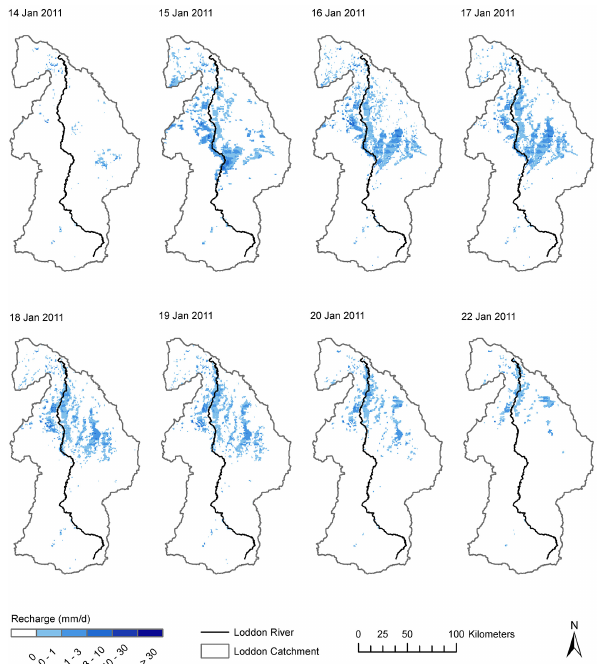
Fig. 2. Time series of flood recharge maps for the Loddon catchment showing the progression of flood recharge down the catchment with time.